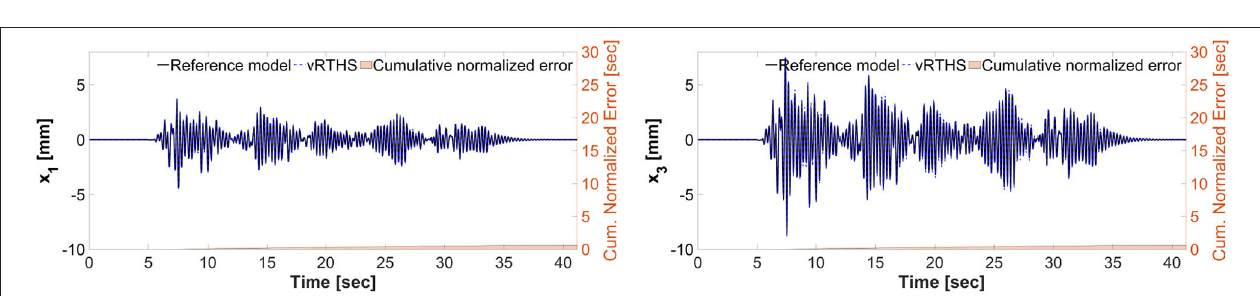
FIGURE 17 | Study 3 (Case 4): vRTHS response comparisons of the 1st and 3rd floor displacements under El Centro excitation.